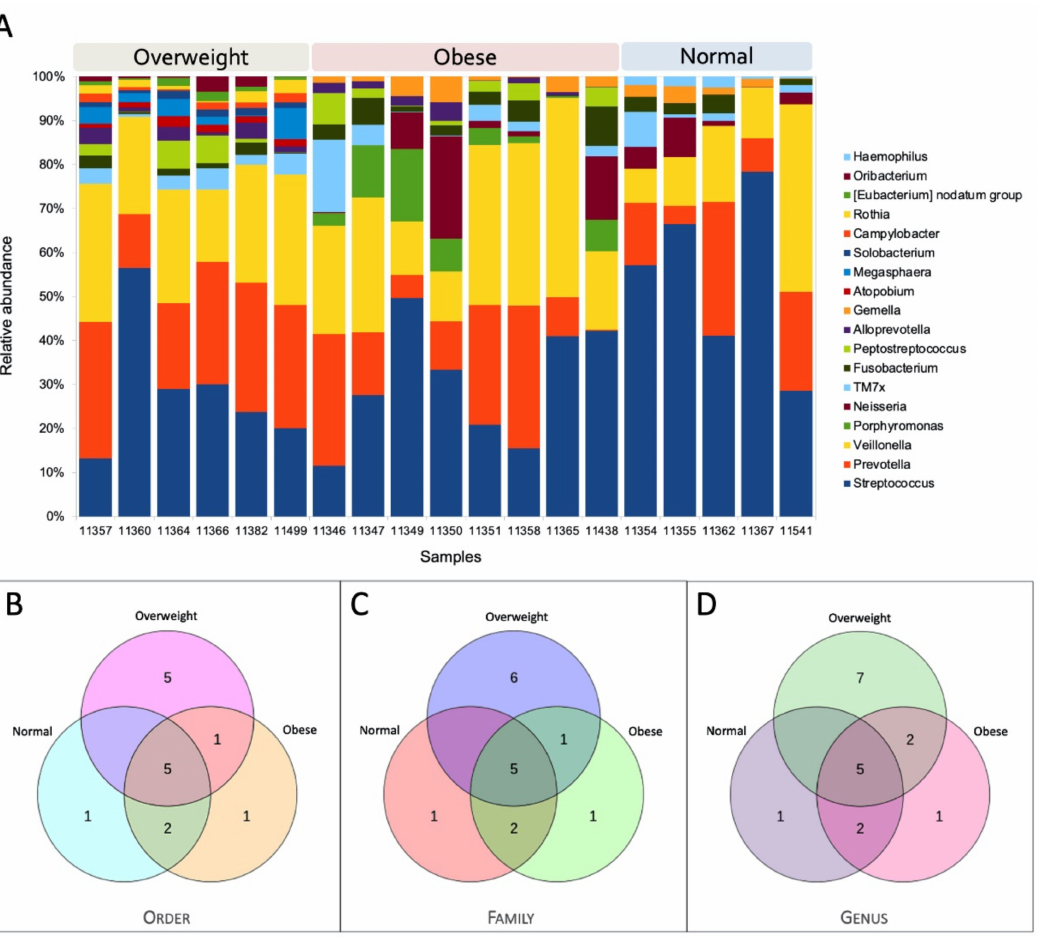
Figure 3. Core microbiome structure. ( A ) Bar plot showing the relative abundance of the core microbiome in each individual; ( B – D ) Venn diagrams showing the number of overlapping core microbial taxa based on the microbial taxonomic hierarchy—( B ) order; ( C ) family; ( D )